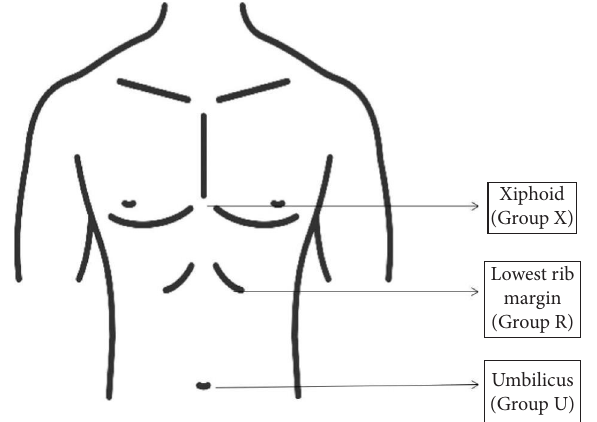
Figure 1: Height of the operating table corresponding to the operator’s umbilicus (Group U), lowest rib margin (Group R), or xiphoid process (Group